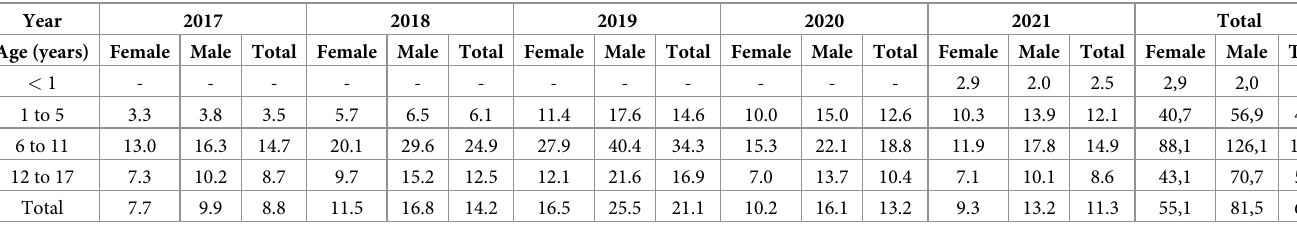
Table 2. Prevalence of sleep apnea in children and adolescents, Colombia, 2017–2021.